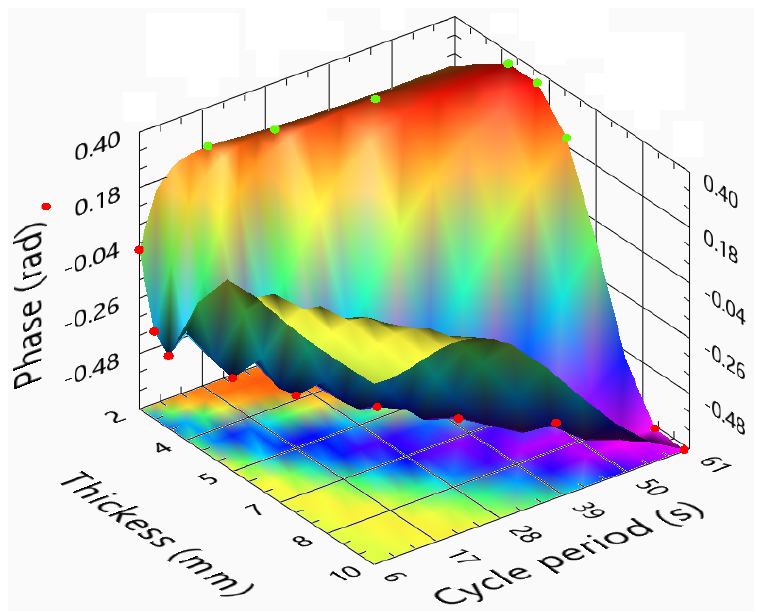
Figure 15. Phase difference function of the sample thickness and cycle period for PMMA